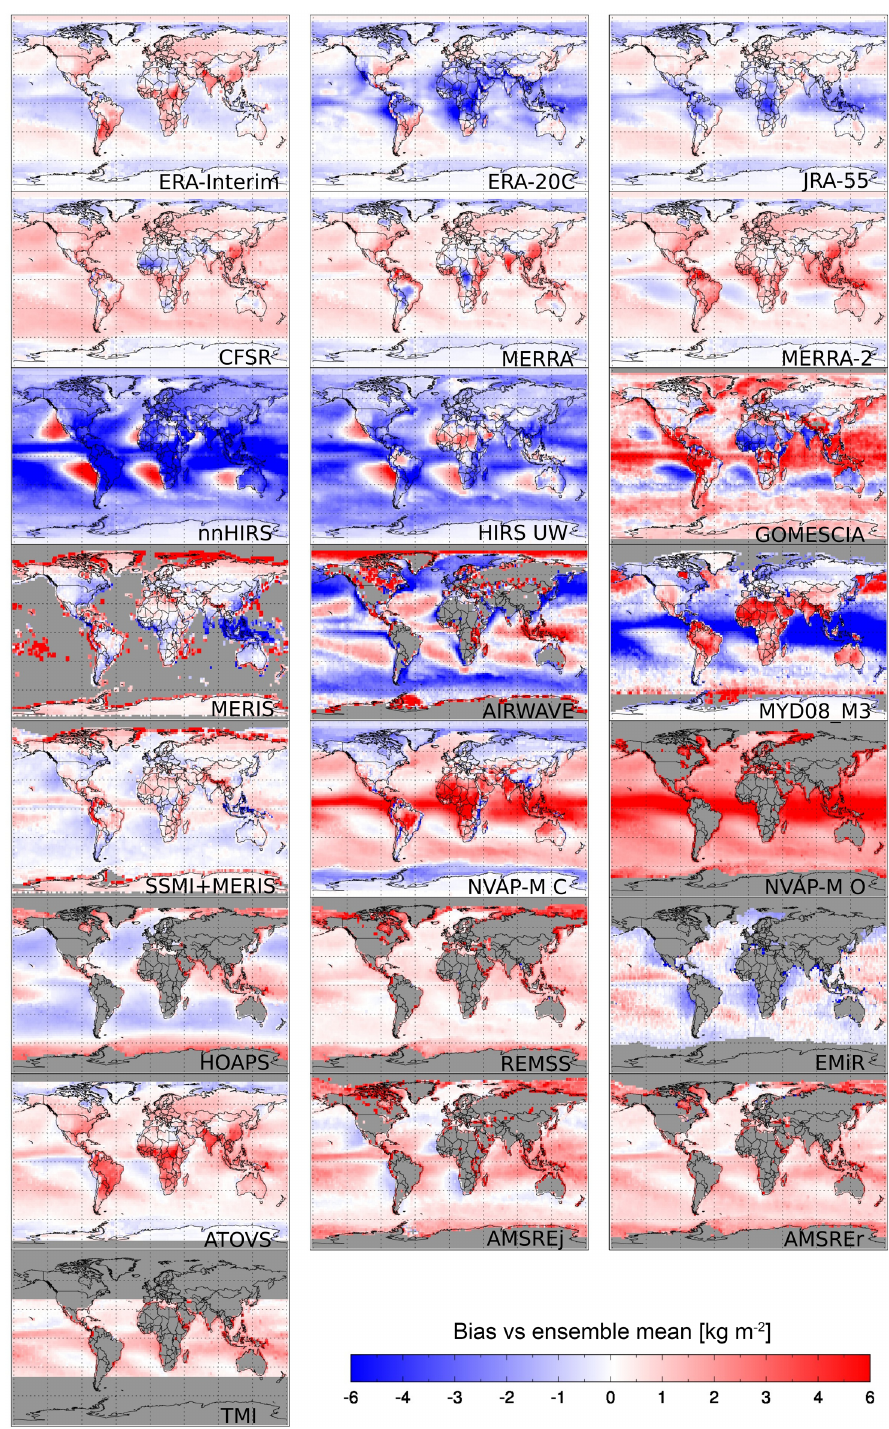
Figure 3. TCWV bias relative to the ensemble mean for all elements of the G-VAP data archive. Partly the panels include unambiguous abbreviations of the data record names, with the following exceptions: AMSR-E JAXA (AMSREj), AMSR-E REMSS (AMSREr), Merged Microwave REMSS